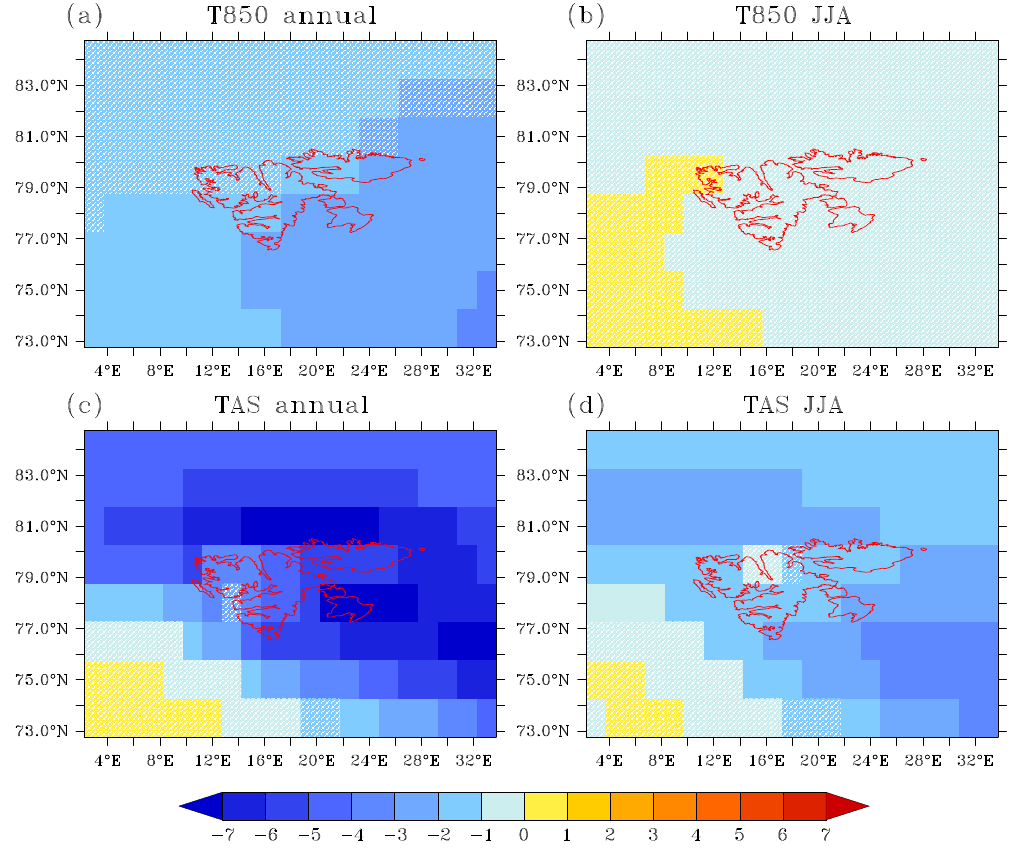
Figure 10. (a) Annual 850hPa temperature (T850) difference ( ◦ C) between MIROC5 and ERA-Interim over 1980–2005. (b) Same as (a) but in summer (JJA). (c) Same as (a) but for the near-surface temperature (TAS, ◦ C). (d) Same as (c) but in summer (JJA). The non-hatched areas correspond to the areas for which the difference is significant at the 95% confidence